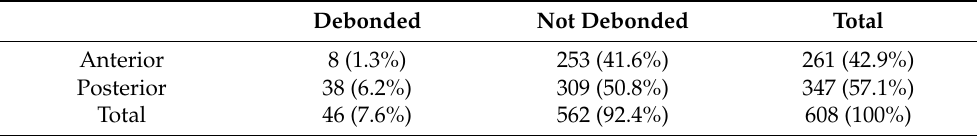
Table 4. Chi-squared test for debonding frequency between anterior and posterior brackets. Debonded Not Debonded Total Anterior 8 (1.3%) 253 (41.6%) 261 (42.9%) Posterior 38 (6.2%) 309 (50.8%) 347 (57.1%) Total 46 (7.6%) 562 (92.4%) 608 (100%) Values are reported as frequency (percentage); Chi-squared test = 13.25, p <